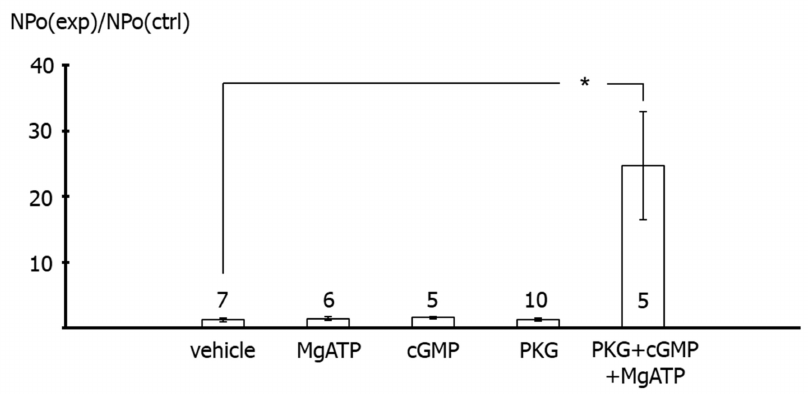
Figure 9. Effect of PKG on excised BK channels of rat tail artery smooth muscle cells. Data are expressed as the ratio of BK channel activity (NPo) at the end of the application period under specified experimental conditions (NPo(exp)), i.e., application of 100 µ M MgATP, 100 µ M cGMP, 6 U/ µ L PKG, PKG together with MgATP and cGMP, and experimental bath solution in the time control series (vehi- cle), to BK channel activity before the beginning of the application period under the same conditions (NPo(ctrl)); number of cells investigated appears near the bar for each condition. *— p <